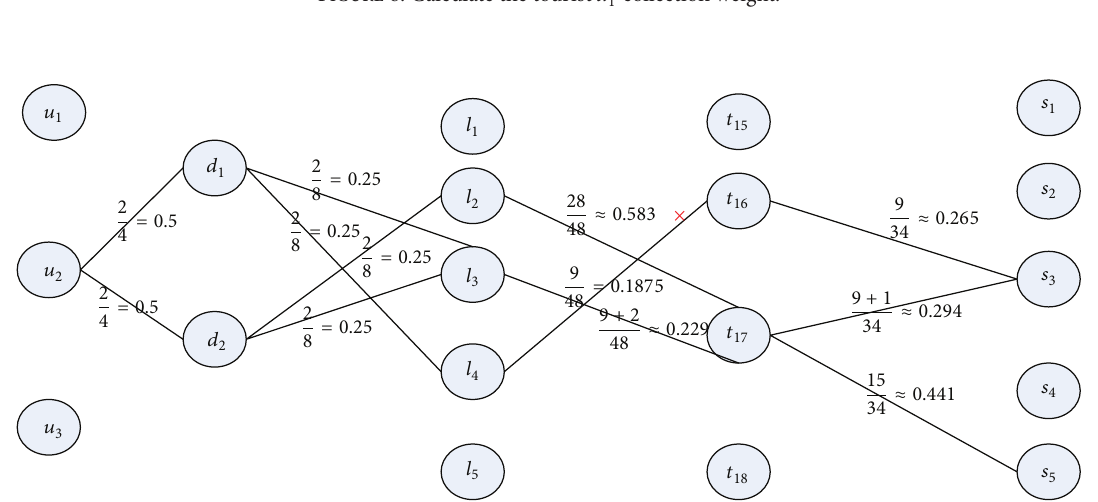
Figure 8: Calculate the tourist 𝑢 1 collection weight.